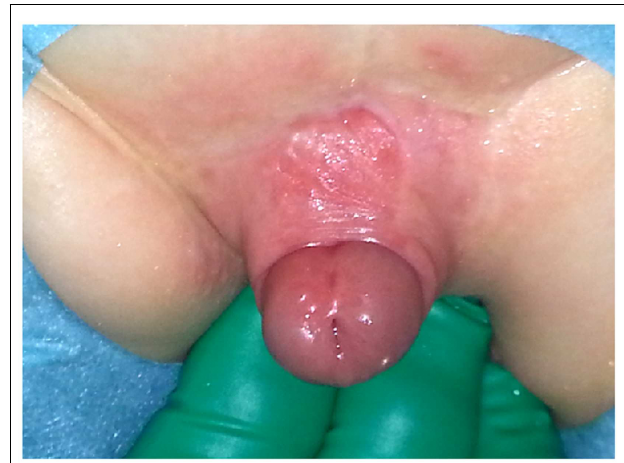
FIGURE 6 |TPF used for dorsal skin coverage in a case of epispadias (Courtesy Dr.Anja Lingnau, Universitätsmedizin Berlin